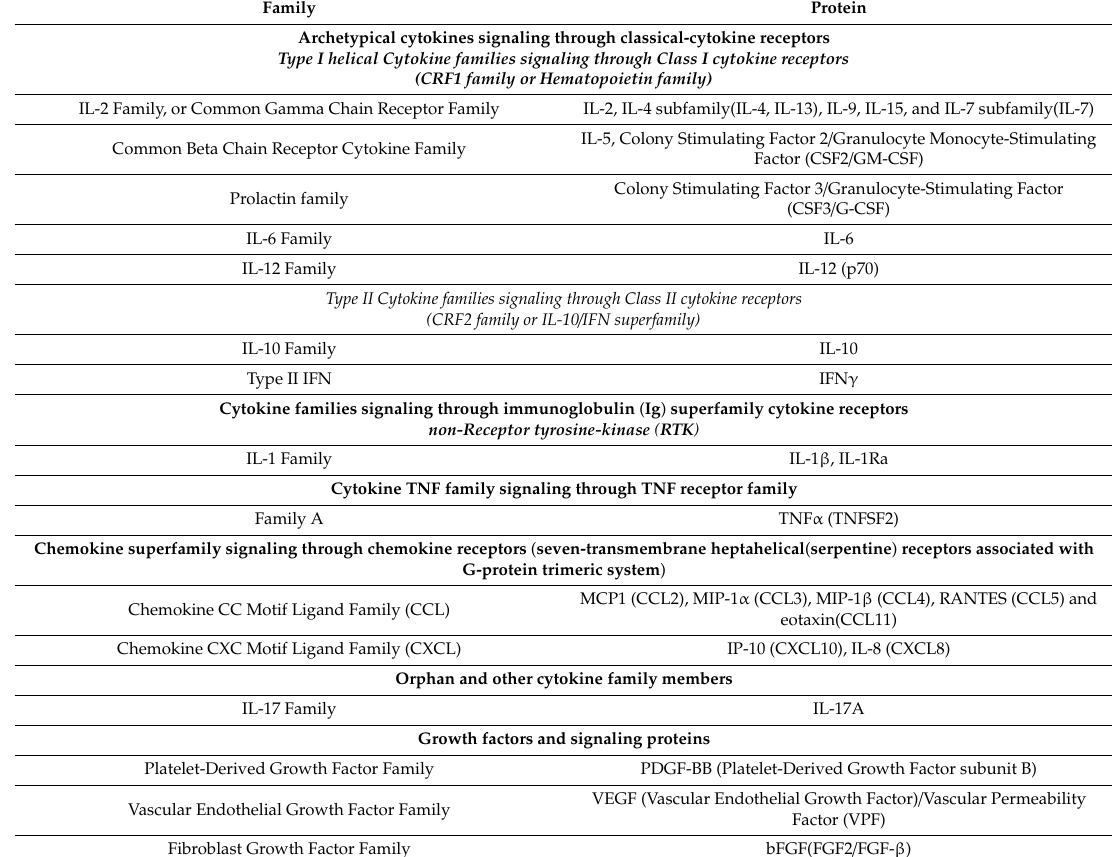
Table A2. Panel of cytokines and growth factors assessed in the